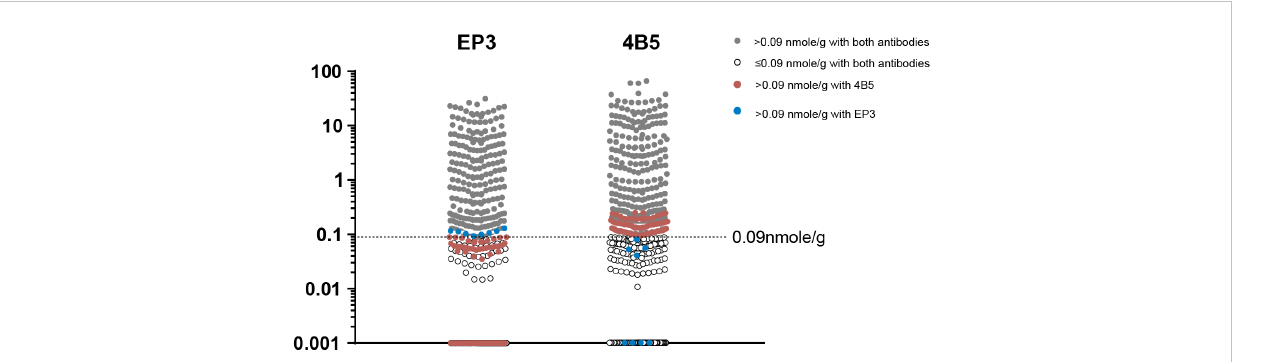
FIGURE 5 The distribution of specimens with (Her2-E) and without Her2 expression (Her2-0) strati fi ed by limit of detection (LOD) of QDB analysis using either EP3 or 4B5 antibodies. The LODs of QDB analysis with both 4B5 and EP3 antibodies were at 0.09 nmol/g. Specimens with Her2 levels above 0.09 nmol/g with both antibodies were in gray color while those below 0.09 nmol/g were in the white circle. Specimens with Her2 levels above 0.09 nmol/g only when measured using the 4B5 antibody were in brown color while those only with the EP3 antibody were in blue